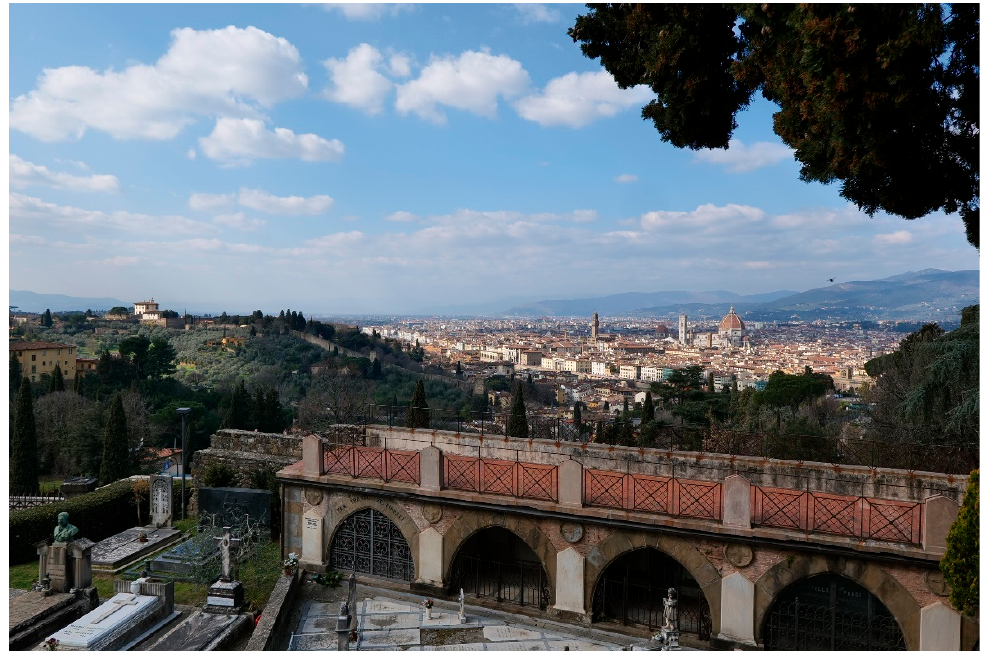
Figure 1. The view of Florence today from San Miniato, as it was from more than a century ago, gave Simmel a reason to reflect on the composition of landscape based on the aesthetics of landscape painting. Taking composition patterns borrowed from landscape painting, certain groups of elements (such as blades of grass and flowers to meadow) are aggregated and then subjected to the synthesis “landscape”. An essential element of the synthesis to landscape at Simmel’s time was (it is partly until today) the attribution of the seen elements as “natural”. If objects are clearly of human origin, they are supposed to originate from pre-modern times (Photo: Olaf Kühne 2022).